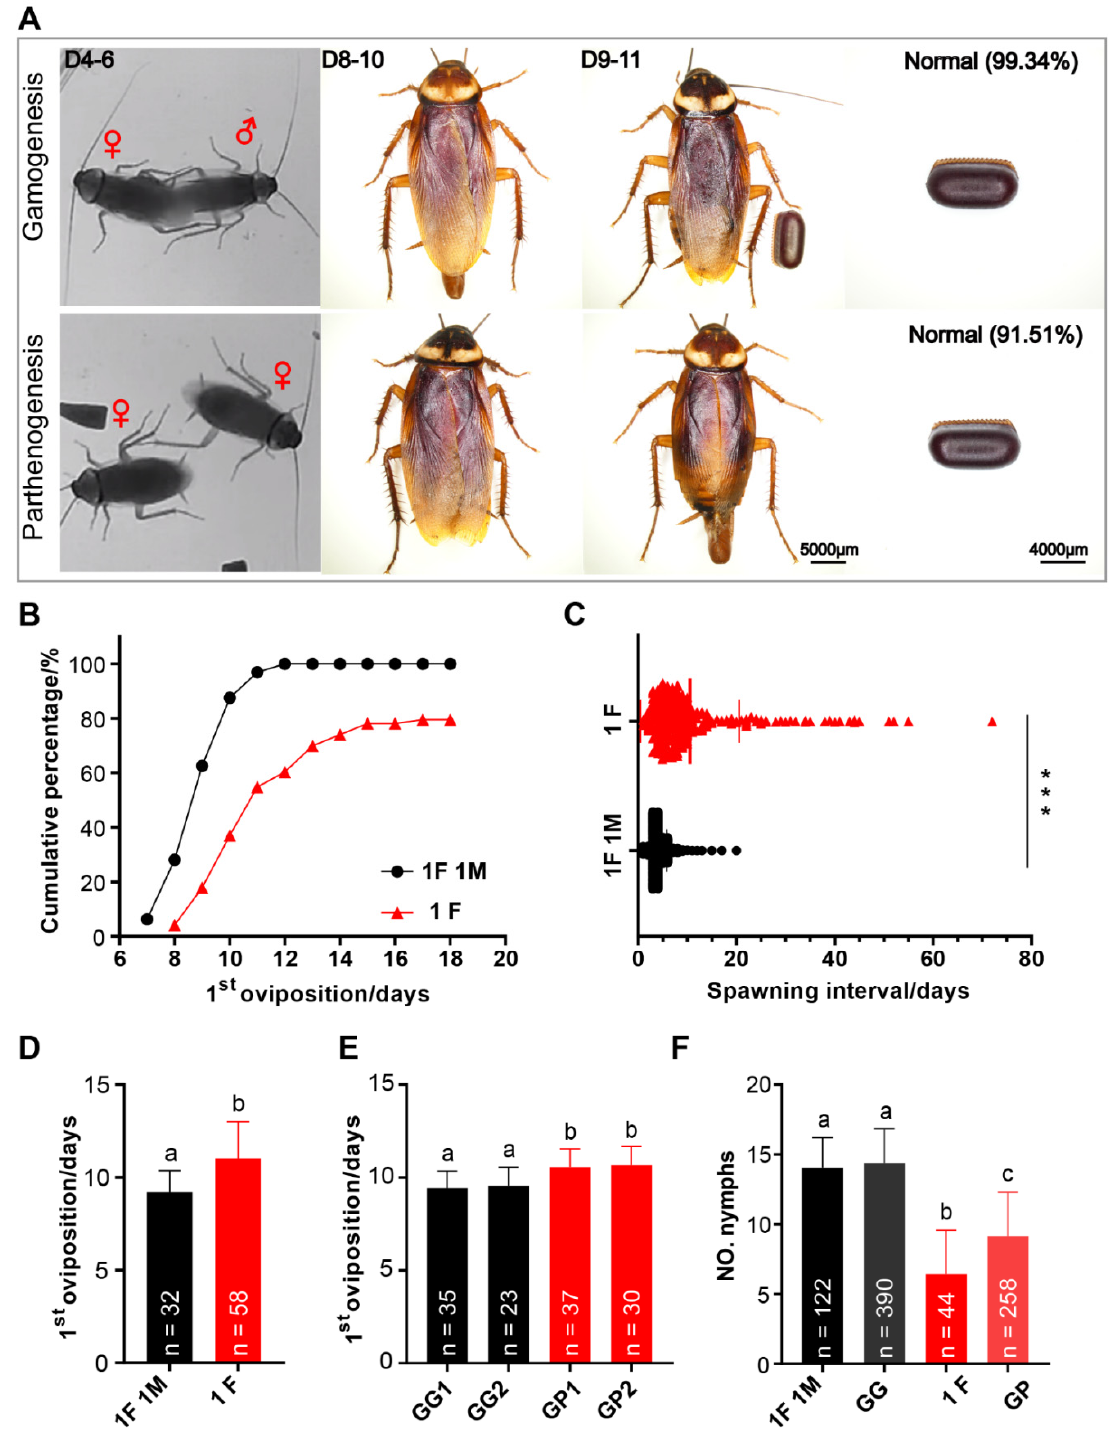
Figure 7. Reproduction of P. americana . ( A ) An overview of the first oviposition cycle. Red symbol ♀ indicates female adult and ♂ indicate male adult. Scale bars of adult: 5000 μ m. Scale bars of ootheca: 4000 μ m. ( B , D ) The time of the first oviposition while housed alone or in pairs. ( C ) The spawning interval was calculated by averaging the individual spawning intervals by unmated and mated. *** p < 0.001. ( E ) The time of the first oviposition while group-housed. ( F ) The number of nymphs hatching from the gamogenetic or parthenogenetic ootheca. 1F: one female; 1M, one male; GG, group-housed gamogenesis; GP, group-housed parthenogenesis; GG1, 35 females and 47 males; GG2, 23 females and 32 males. In ( D – F ), means with different letters are significantly different ( p < 0.001).